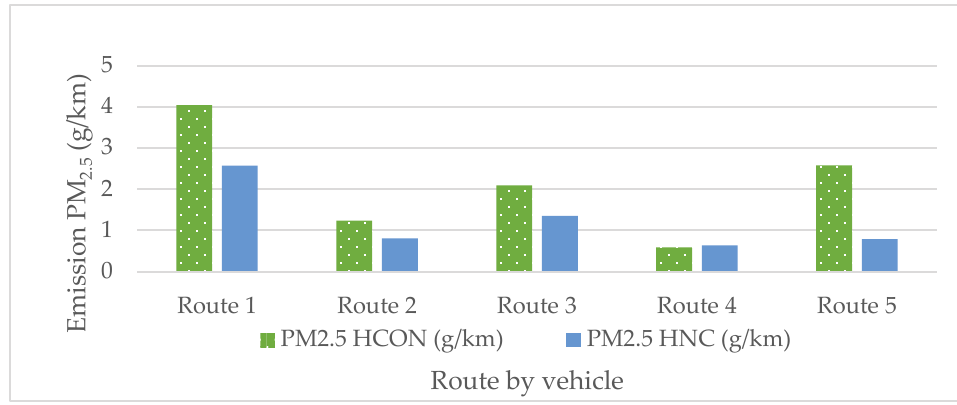
Figure 10. Emission of PM 2.5 in HCON and HNC.